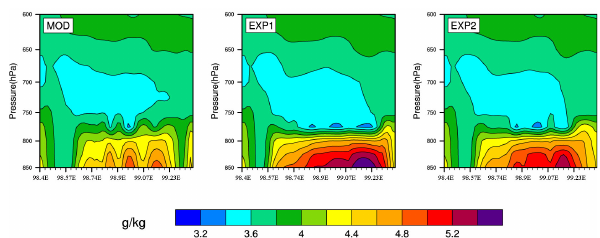
Fig. 10. Vertical latitudinal section of specific humidity at 2m above ground (gkg − 1 ) from the MOD, EXP1 and EXP2 simulations at 13:00BT, 6 July